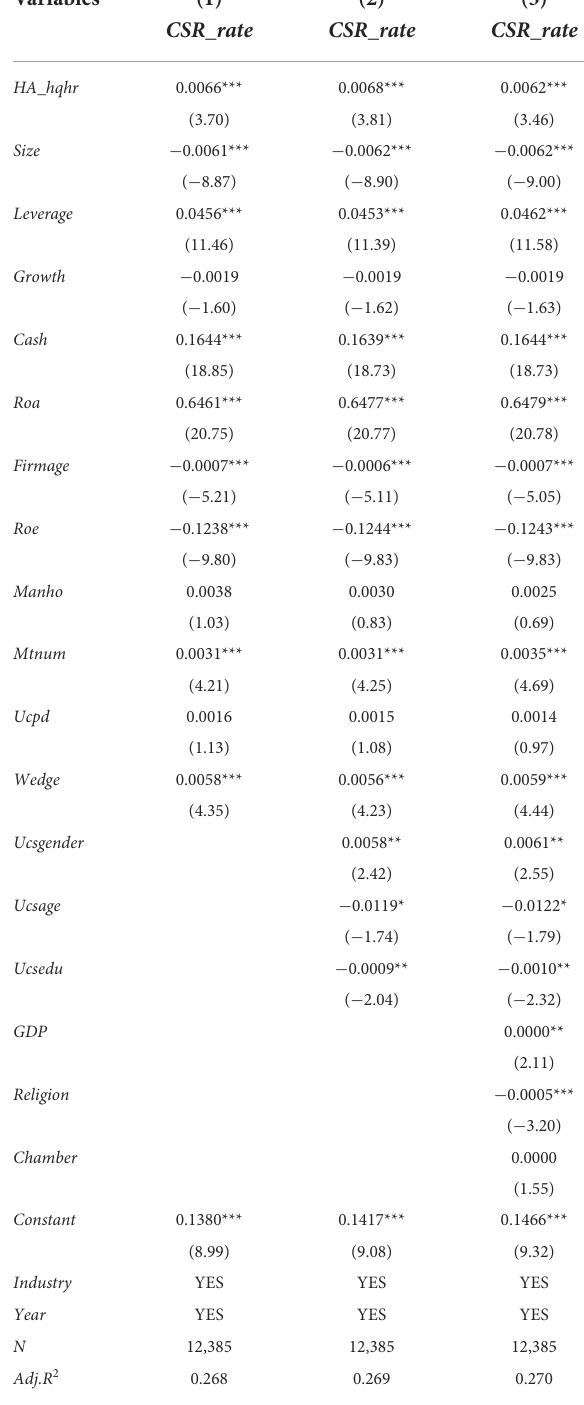
TABLE 5 The effect of the ultimate controller’s HA on CSR